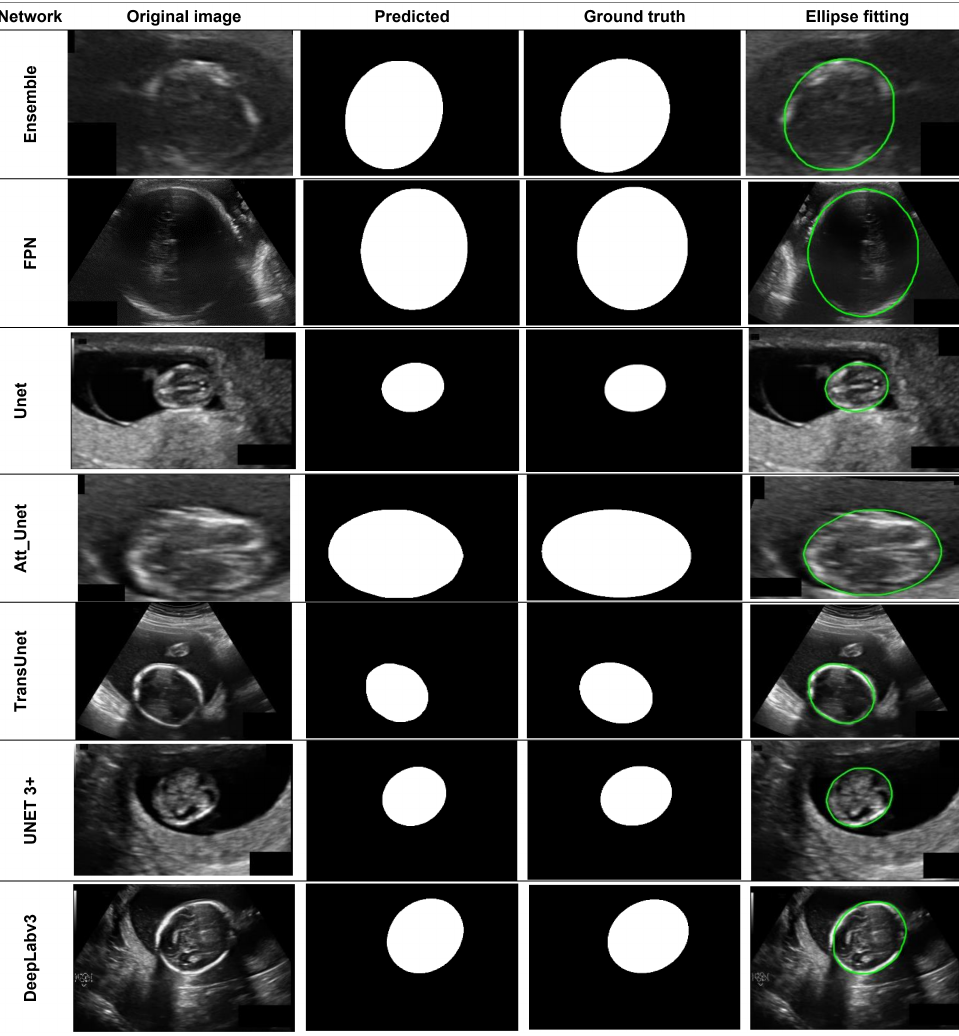
Figure 6. Qualitative comparison of segmentation performance of networks on a fetal head ultrasound image. The predicted mask, ground truth, and original image boundaries are shown. The predicted masks using different networks and the proposed ETLM are shown in the first